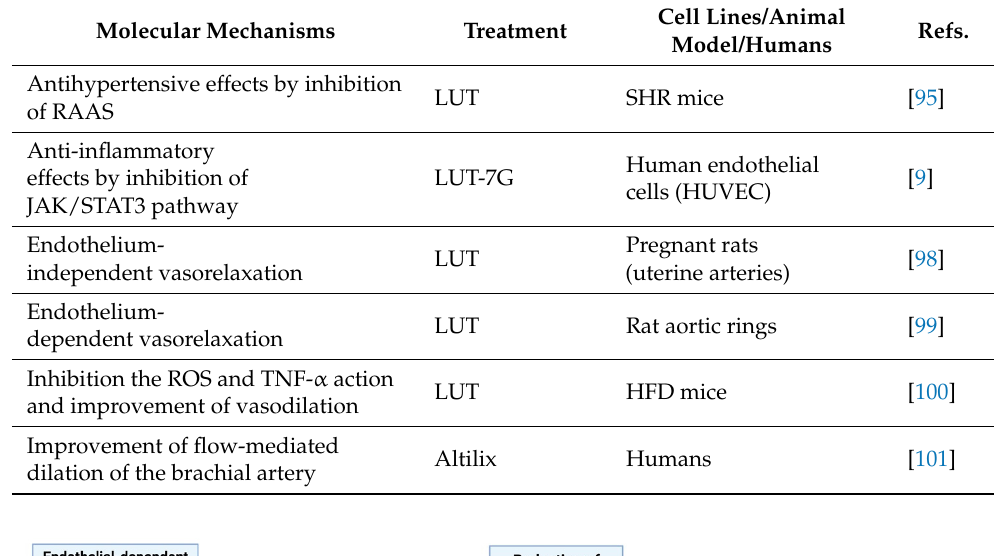
Table 9. Specific effects of treatment with luteolin and LUT-7G on vascular physiology.